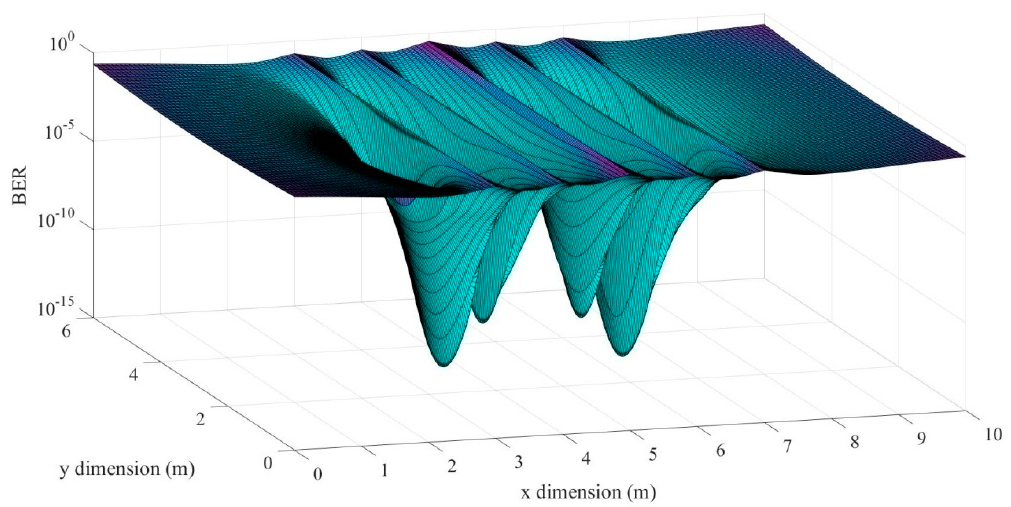
Figure 5. Bit error rate (BER) of the visible light communication (VLC) system under consideration, using the VO 2 optical filter at the receiver.